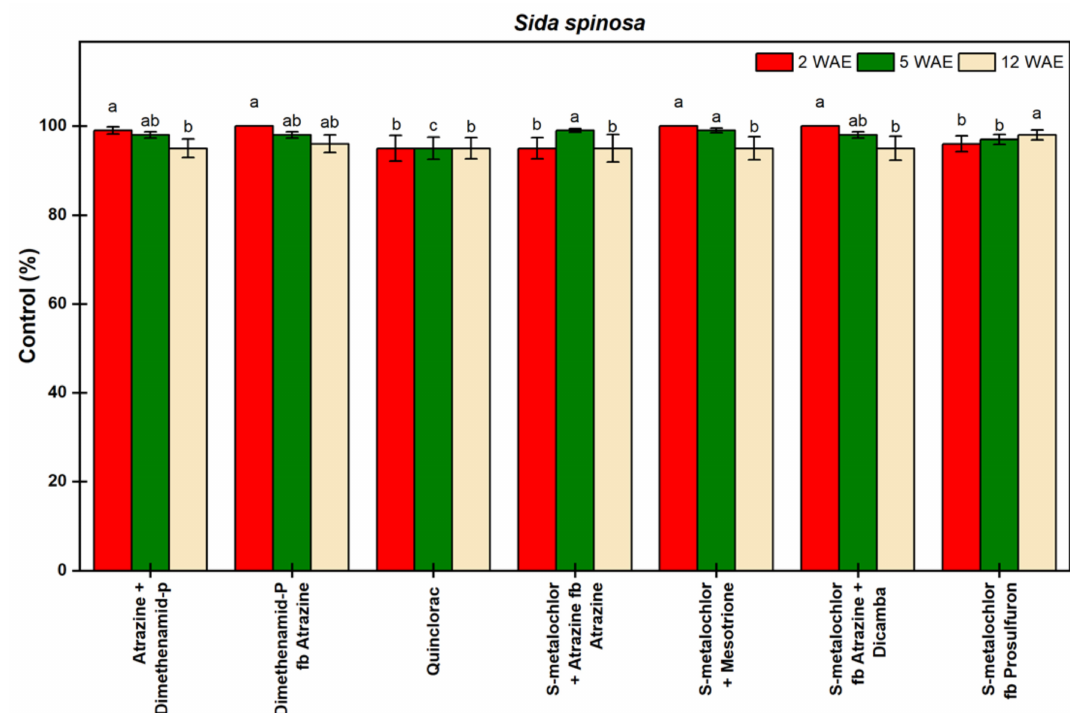
Figure 5. Sida spinosa control with di ff erent herbicide treatments at 2, 5, and 12 weeks after emergence (WAE). Data were analyzed separately for each WAE. Data were pooled over three years. The same letters on bars indicate no significant di ff erences at p < 0.05, according to Fisher’s least significant di ff erence